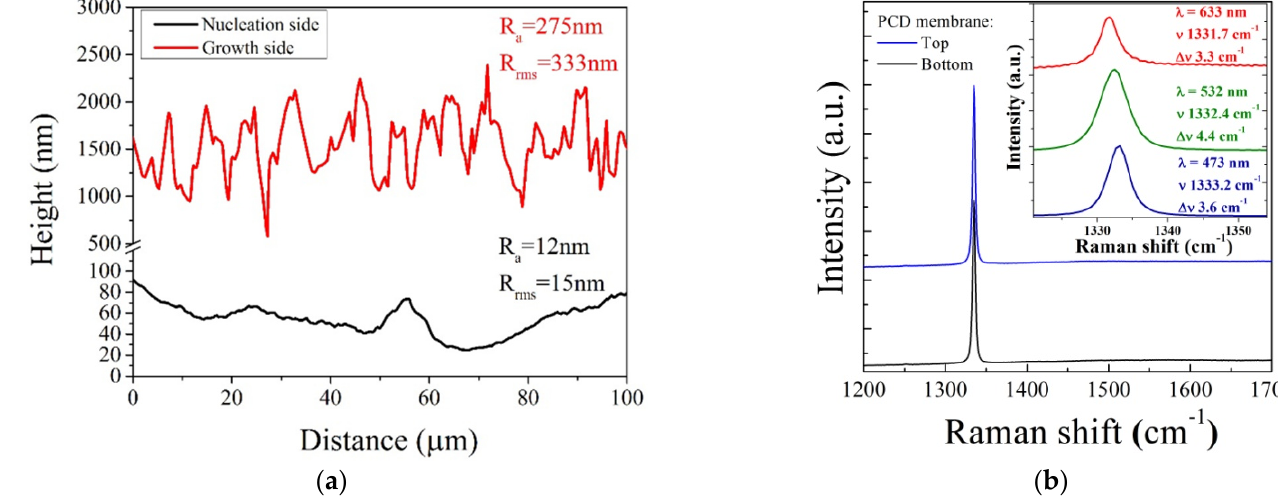
Figure 7. ( a ) Roughness of a polycrystalline diamond membrane surface at the growth and nucleation sides, as measured by optical profilometry. Note the difference in scale on the vertical axis for the two sides. ( b ) Raman spectra of the diamond membrane, taken at the 473 nm excitation wavelength on the top (growth) surface (blue spectrum) and fine-grained bottom surface (black spectrum). Inset: Raman spectra with a diamond peak at about 1332 cm − 1 in the narrow range, taken at the 473, 532, and 633 nm wavelengths for growth surface. The peak position ν and width (FWHM) Δ ν are indicated.